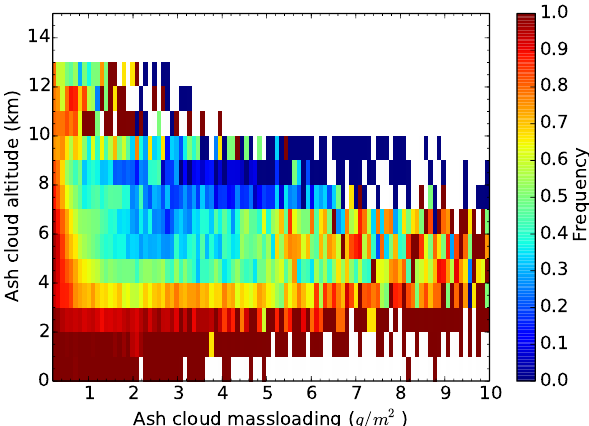
Figure 10. The relative frequency of false negatives (undetected ash pixels normalized to the number of Flexpart pixels) as a function of Flexpart ash mass loading and ash cloud altitude for the Eyjafjal- lajökull 2010 eruption. Results from cloudy simulation. Cloudless results are similar. certain locations and as a result, further increases the number of false positives. See also discussion in Sect. 5. To further understand why far fewer pixels are identified as ash than are present in the Flexpart simulated ash fields, the frequency of false negatives relative to the number of Flex- part pixels is calculated and shown in Fig. 10 as a function of ash cloud mass loading and altitude. It is seen that most ash pixels that miss detection either have a mass loading less than 0.5 g m − 2 or are below the altitude of 3 km. There are also ash pixels missing detection around 10 km. These are associated with increased emissions of ash on 15 May (Stohl et al., 2011) and are missed due to the presence of clouds. There are also pixels missed around the altitude of 5 km for mass loadings larger than 5 g m − 2 . The ash clouds below the altitude of 3 km may be missed due to either overlying or overlapping clouds or too small temperature difference with the underlying surface, where the radiatively effective sur- face under the ash cloud is the Earth’s surface or an opaque liquid-water cloud. The mostly small difference between the number of false negatives between cloudless and cloud sim- ulations (black lines in Fig. 8) indicates that for the situation during the Eyjafjallajökull (2010) eruption, the small tem- perature difference between the Earth’s surface and the ash cloud due to the low altitude of the ash cloud and small mass loading of the dispersed ash, were the main reasons for the rather large number of false negatives. The presence of clouds tends to obscure ash clouds com- pared to cloudless skies (compare solid and dashed green lines in Fig. 8). The effect of clouds varies as the overlap with the ash cloud changes. The mean of the number of pixels detected (excluding false positives) as ash relative to Flexpart ash pixels for each scene in the cloudy simulations